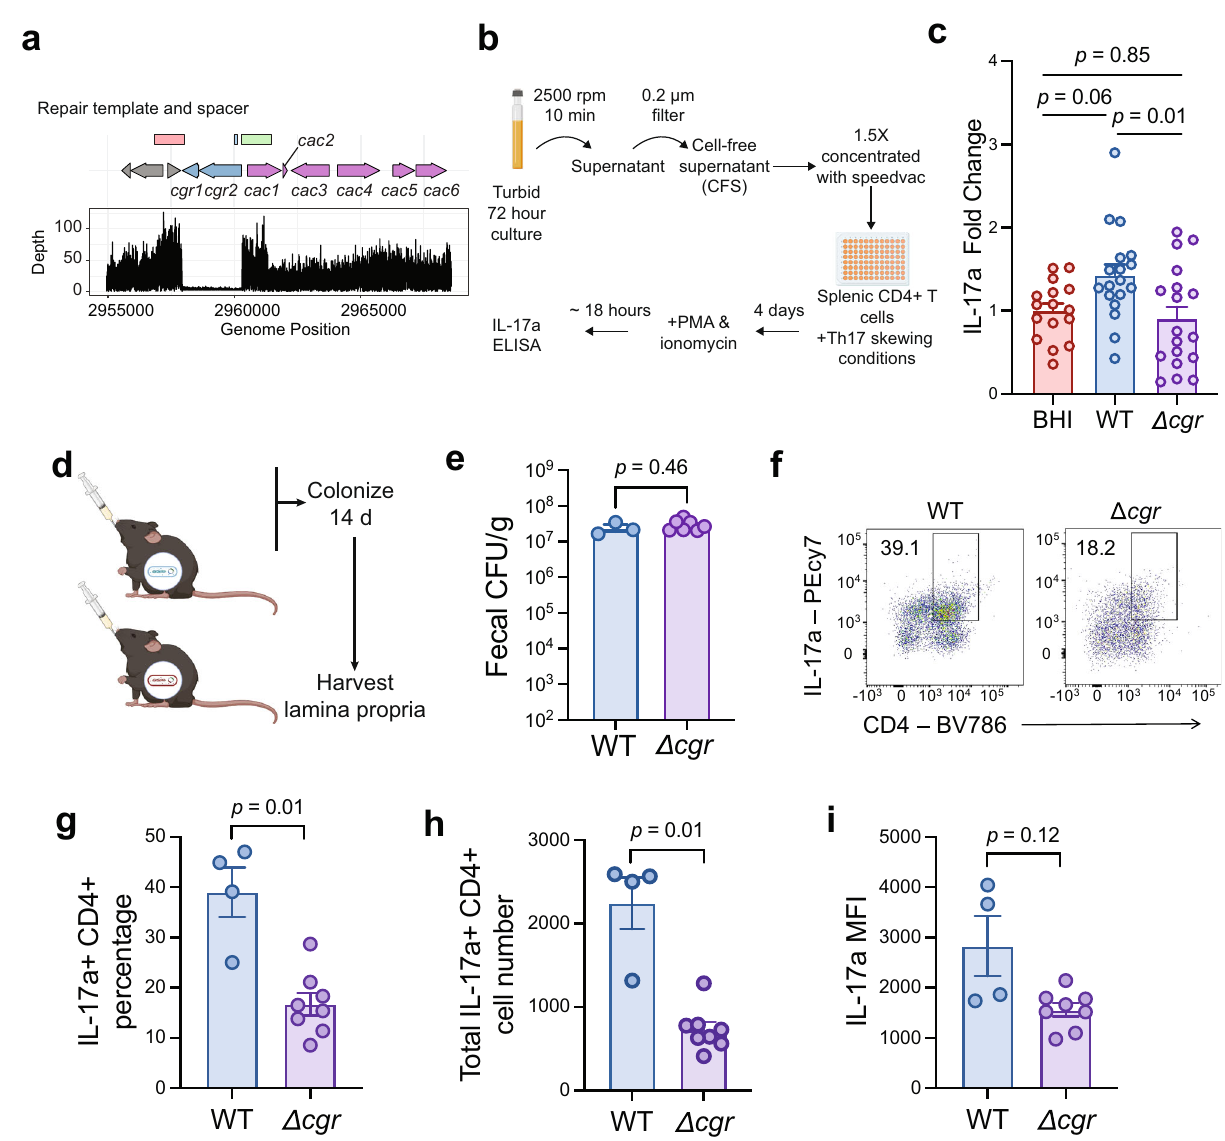
Fig. 8 | Genomic engineering and in vivo experiment show that the cgr operon isnecessaryforcolonicTh17inductionby E.lenta .a Whole genomesequencing con fi rms the targeted deletion of the cgr operon. Additional reads fl anking the deletion site are due to the presence of the editing plasmid in the long-read sequencing run, as indicated by red and green rectangles. b Schematic of in vitro Th17 skewing assay. c Fold-change of IL-17a levels relative to BHI control of CFS from E.lenta WTor Δ cgr . d Experimentaloutlineofmouseexperiment.Germ-free C57BL/6Jmalemiceages6 – 8weekswereseparatedintogroupsandgavagedwith E. lenta WT ( n =4) and Δ cgr (n=8). Bacteria were allowed to colonize for 2 weeks before the lamina propria was harvested. e No signi fi cant differences in E. lenta colonization on day 14. f Representative fl ow cytometry plots of colonic CD4 + IL- 17a + cells within the live CD3 + gate. Percentage of CD4+IL-17a+ cells is displayed